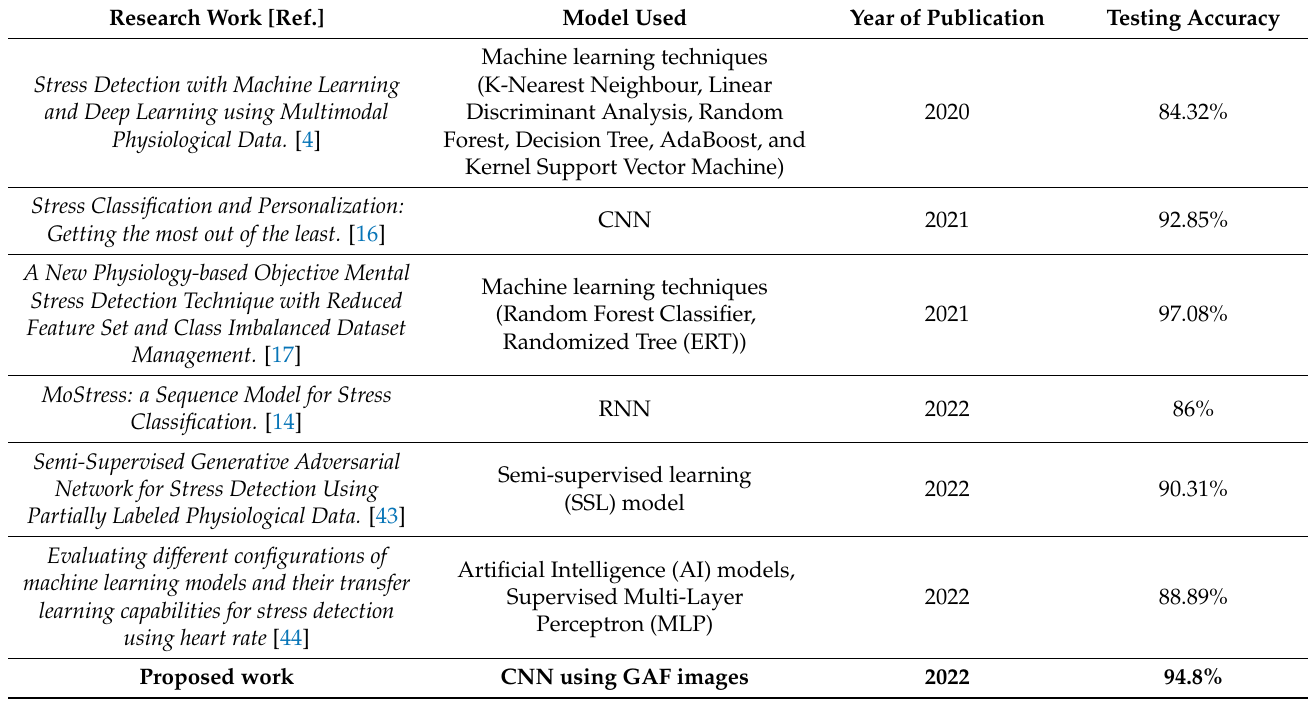
Table 5. Comparison of our proposed image encoding-based deep neural network model with previously proposed works related to WESAD